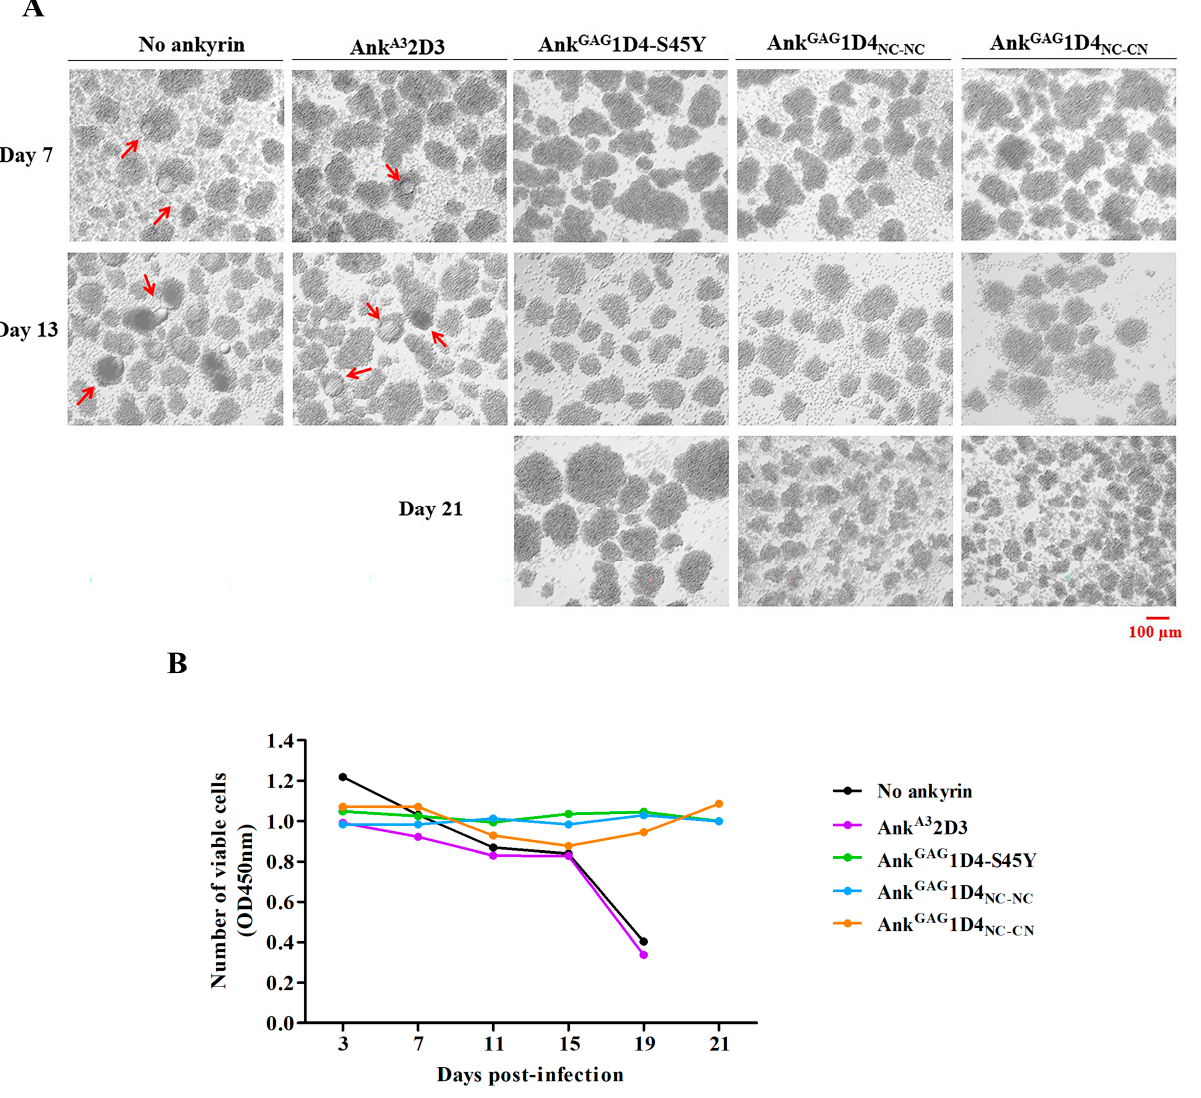
Figure 8. Cell morphology and cell viability of HIV-1 NL4-3 WT infected SupT1 cells. SupT1 and ankyrin-expressing SupT1 cells were infected with 10 MOI of HIV-1 NL4-3 WT virus. ( A ) Cell morphology was observed under inverted microscopy. Cell imaging was performed at 10 × magnification using Zeiss Axio vert A1. The image shown in this figure is representative of several image fields. Scale bar: 100 µ m. The arrows point to syncytium cells which are observed in infected cells. ( B ) Cell viability of infected cells was determined by CCK-8 assay. The data represent the mean from triplicate wells. Ank A3 2D3, Ank GAG 1D4-S45Y, Ank GAG 1D4 NC-NC and Ank GAG 1D4 NC-CN represent SupT1 cells expressing Myr (+) Ank A3 2D3-EGFP, Myr (+) Ank GAG 1D4-S45Y-EGFP, Myr (+) Ank GAG 1D4 NC-NC -EGFP, and Myr (+) Ank GAG 1D4 NC-CN -EGFP, respectively. HIV-1 production in HIV-1 infected SupT1 cells and ankyrin-expressing SupT1 cells was evaluated using HIV-1 p24 ELISA. During culture, the culture supernatant of 7, 13, and 21 days post-infection was harvested and tested for HIV-1 CAp24 level by ELISA. At 7 days post-infection, the level of HIV-1 p24 in the culture supernatant of SupT1 and Ank A3 2D3-expressing SupT1 cells was detected at 1.39 × 10 4 and 1.02 × 10 4 pg/mL (Figure 9A). Whereas, Ank GAG 1D4-S45Y, Ank GAG 1D4 NC-NC , and Ank GAG 1D4 NC-CN showed a higher potency to suppress HIV-1 propagation. Although Ank GAG 1D4-S45Y suppressed HIV-1